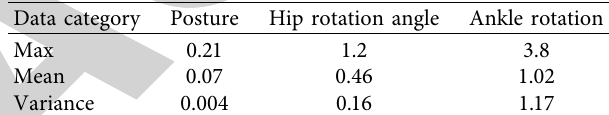
Table 5: Statistics of each error value before the embedded control biped robot experiment.